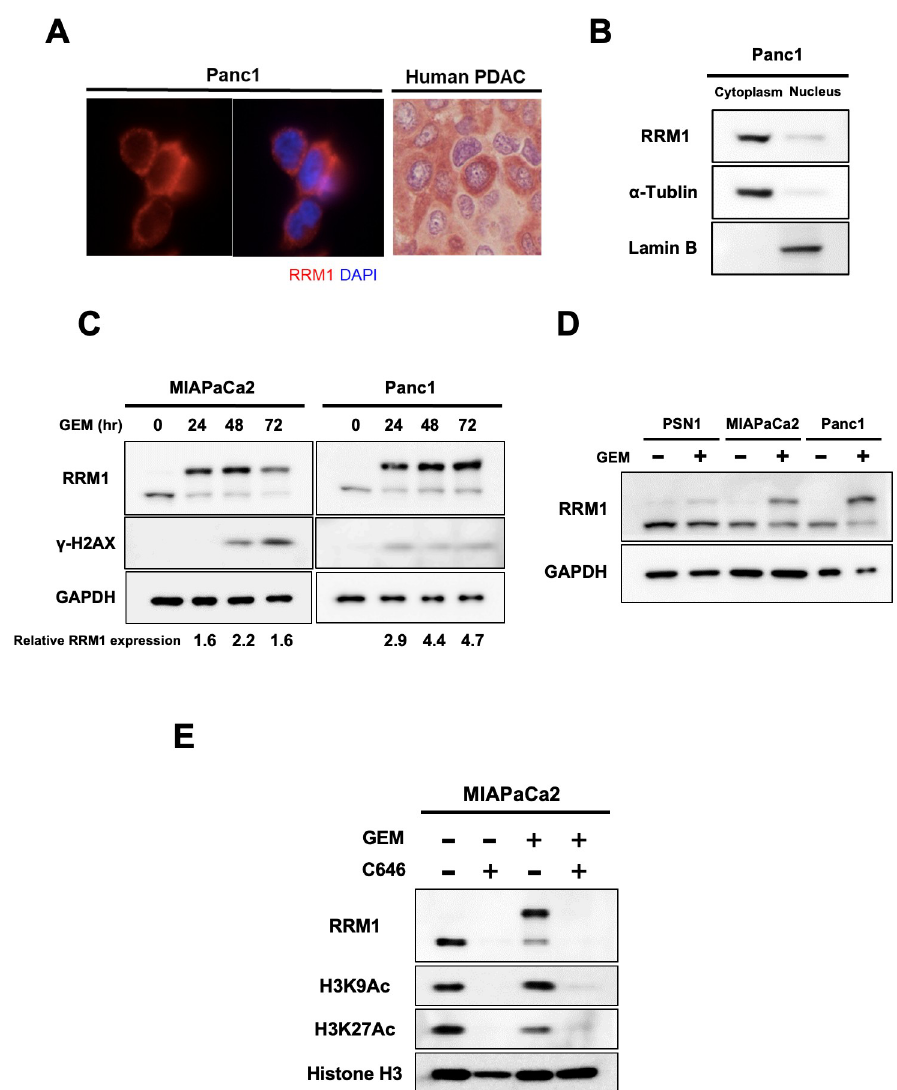
Fig 4. Alteration of RRM1 expression after gemcitabine exposure in pancreatic cancer cells. (A) Representative immunofluorescence of Panc1 cells and immunohistochemical staining of human pancreatic cancer cells for RRM1 expression showing that RRM1 is mainly localized in the cytoplasm. (B) Distribution of RRM1 in Panc1 cells. Proteins were separated into nuclear and cytoplasm fractions and examined by Western blotting. RRM1 was confirmed to be located in the cytoplasm. ( C) Expression levels of RRM1 induced by gemcitabine from 24 hours to 72 hours. DNA damage was evaluated by γ -H2AX expression. Cells were treated with gemcitabine at 100 nM for MIAPaCa2 and 1 μ M for Panc1 cells. RRM1 expression change with upper band shifting was observed at 24 hours after gemcitabine exposure. The numbers at the bottom indicate the relative intensity of the bands for upper band shifted RRM1 expression after gemcitabine exposure comparting to corresponding controls of original RRM1 intensity with no gemcitabine treatment (normalized by GAPDH). (D) Effects of gemcitabine treatment on RRM1 expression level in PSN1, MIAPaCa2, and Panc1 cells. The cells were treated with gemcitabine for 72 hours (at 10 nM for PSN1, 20 nM for MIAPaCa2, and 1 μ M for Panc1). The doses of gemcitabine for each cell line were selected to have the sufficient cytotoxic effect of gemcitabine (S2B Fig). Gemcitabine exposure induced band shifted RRM1 alteration in pancreatic cancer cells. (E) Effects of C646 on expression levels of RRM1. Cells were pretreated with C646 at 50 μ M for 24 hours and then treated additionally with gemcitabine at 25 nM for 24 hours. Acetylation status was evaluated by H3K27 and H3K9 expression using Western blotting. C646 decreased original RRM1 expression and band shifted RRM1 expression induced by